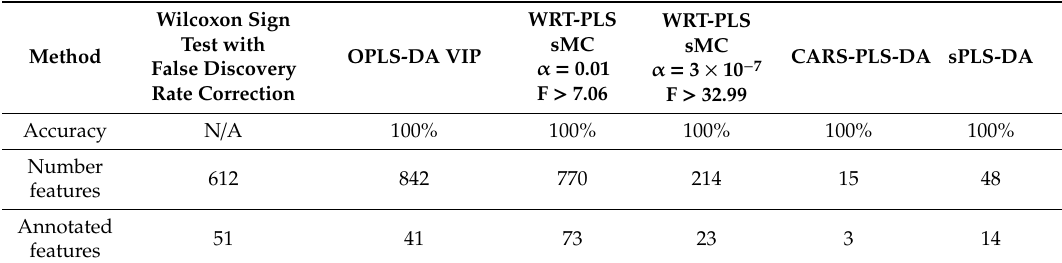
Table 2. Overview of results of di ff erent methods to distinguish patients with A–T before and during treatment with nicotinamide riboside.